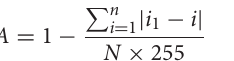
The variance evaluation index can be expressed as Equation (2), where S denotes the mean-variance, L ( i , j ) represents the value corresponding to the coordinates of the original image ( i , j ), and B ( i , j ) the value associated with the coordinates of the denoised image ( i , j ). When the value of S is closer to 0, the higher the similarity between the original and denoised images, the better the denoising